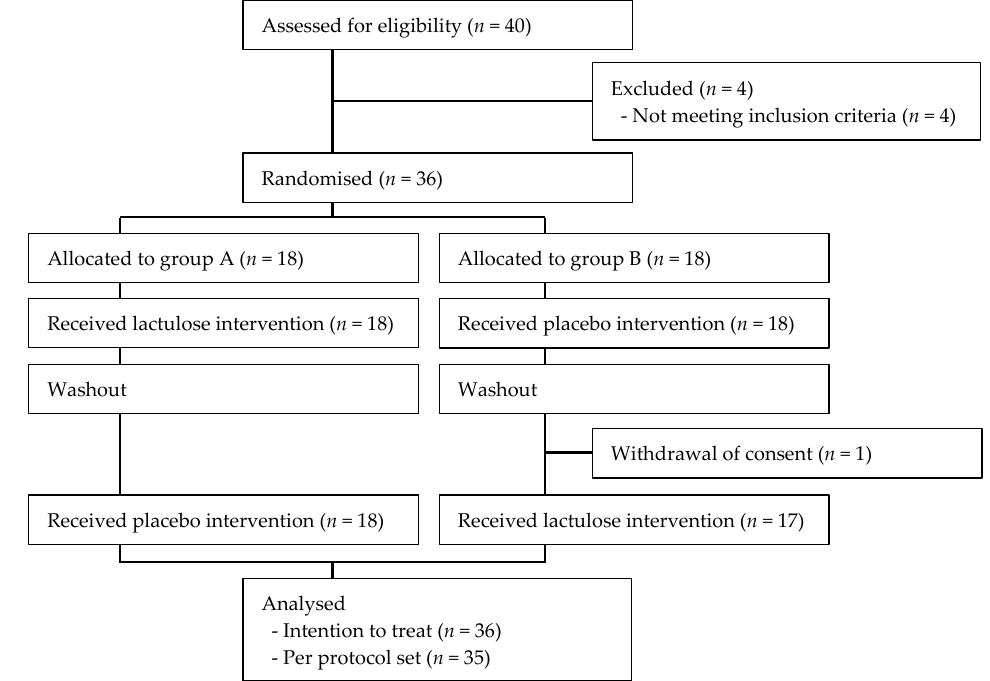
Figure 1. Flow chart of participant numbers throughout the trial.